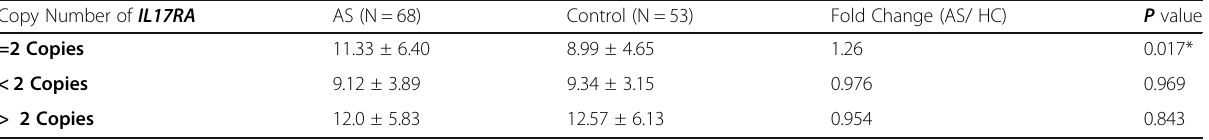
Table 4 IL17RA mRNA expression in AS and healthy control groups adjusted by the copy number of IL17RA Copy Number of IL17RA